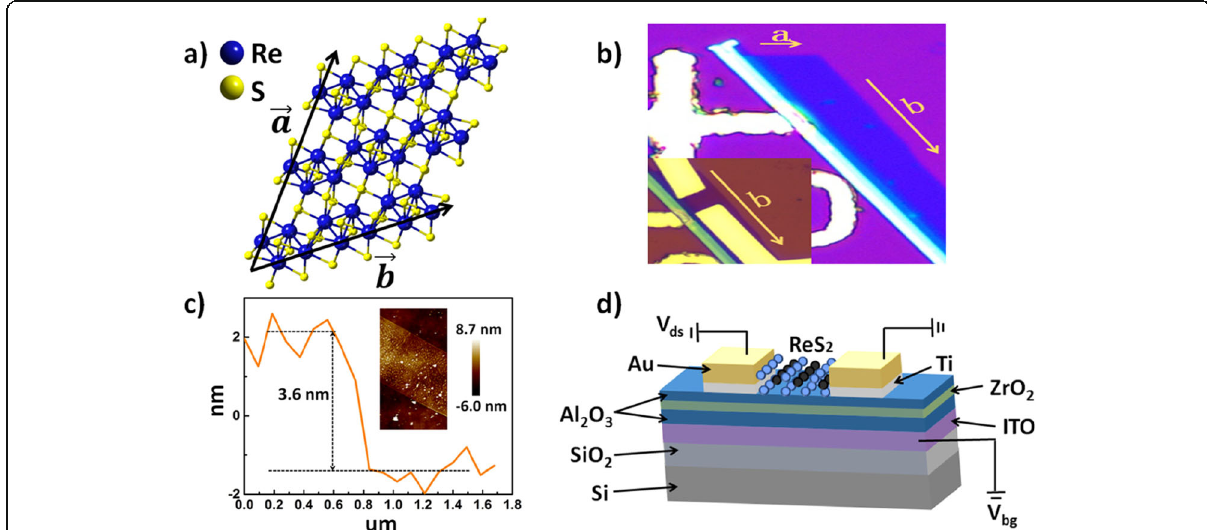
Fig. 1 The synaptic devices based on ReS 2 2D material. a Crystal structure of monolayer ReS 2 . b Optical image of a five-layer ReS 2 flake. Inset: source and drain electrodes patterned on the ReS 2 flake; direction b is taken as the direction of channel current. c The AFM image and height profile of the ReS 2 flake. d Schematic diagram of a 2D material ReS 2 synaptic device. The thickness of the Al 2 O 3 , ZrO 2 , and Al 2 O 3 stack (from bottom) is 12 nm, 4 nm, and 4 nm,